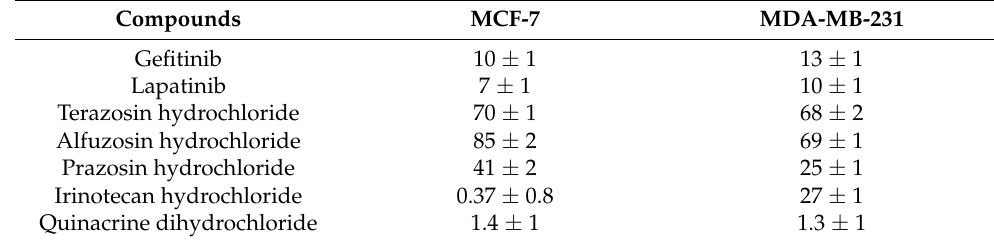
Figure 7. Percentage of cell viability from the biological study in the breast cancer cell line MDA-MB-231, ( A ) gefitinib; ( B ) lapatinib; ( C ) terazosin; ( D ) alfuzosin; ( E ) prazosin; ( F ) irinotecan; and ( G ) quinacrine. All assays were performed in triplicate. Table 6. Cytotoxic activity (IC 50 values in µ M *) in two breast cancer cell lines at 48 h of